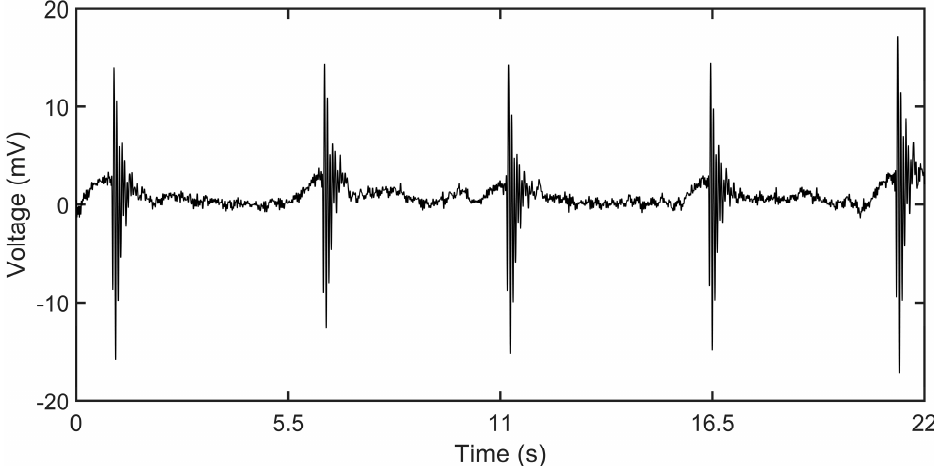
Figure 10. Sensor voltage output of the impact hammer on the string.